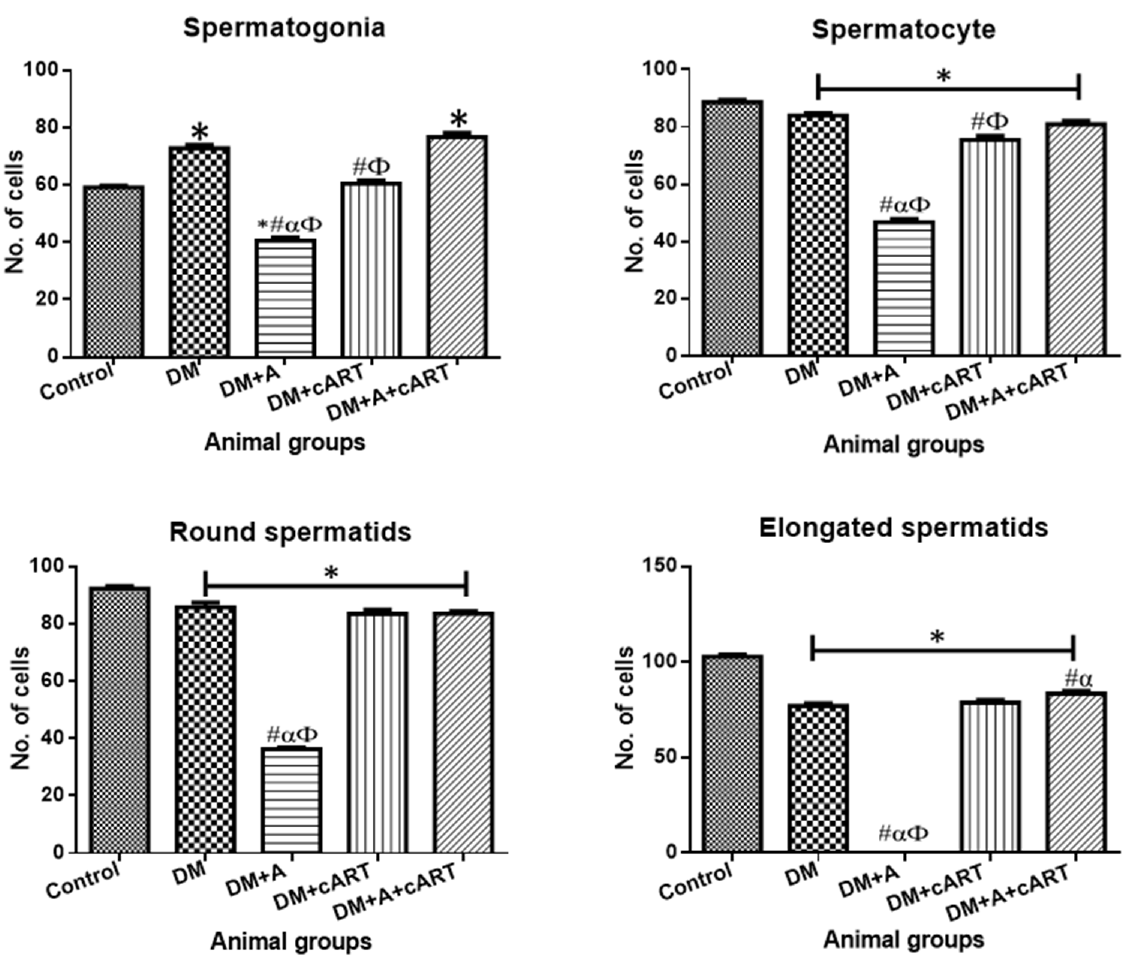
Figure 1. Graphs showing the mean ± SEM spermatogenic cell counts. The symbols *, #, α , and φ represent significant differences ( p < 0.05) as analyzed by the Bonferroni’s multiple comparison test: ‘*’ significantly different compared to the control group, ‘#’ significantly different compared to DM, ‘ α ’ significantly different compared to DM+cART, and ‘ φ ’ significantly different compared to DM+A+cART. Key: DM, diabetes; DM+A, diabetes and alcohol; DM+cART, diabetes and combination antiretroviral therapy; DM+A+cART, diabetes and alcohol and combination antiretroviral ther- apy.